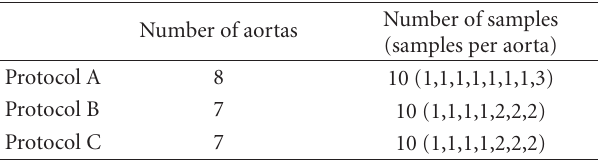
Table 1: Breakdown of number of aortas used per tested protocol and the number of samples derived from each aortic length.